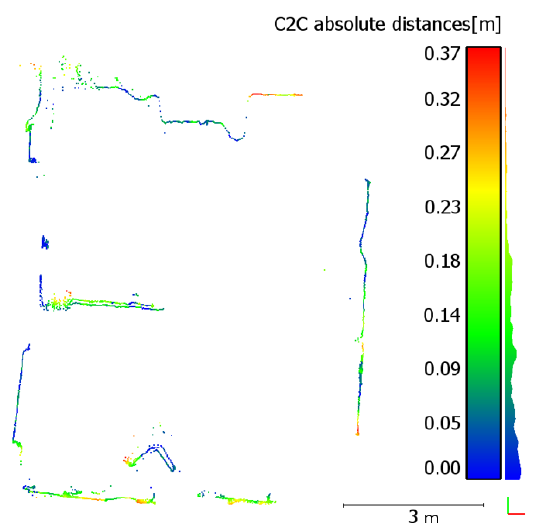
Figure 4. Crazyflie point cloud map, coloured based on point distance to the MAX Kiwi map, in the Berrozi dataset.